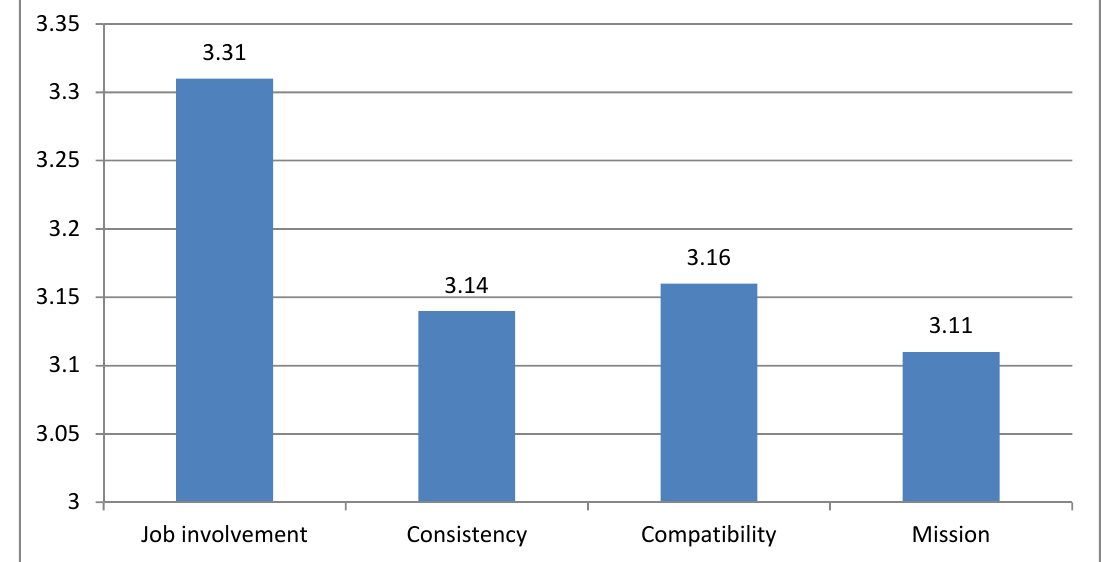
Fig. 2. Mean score of different components